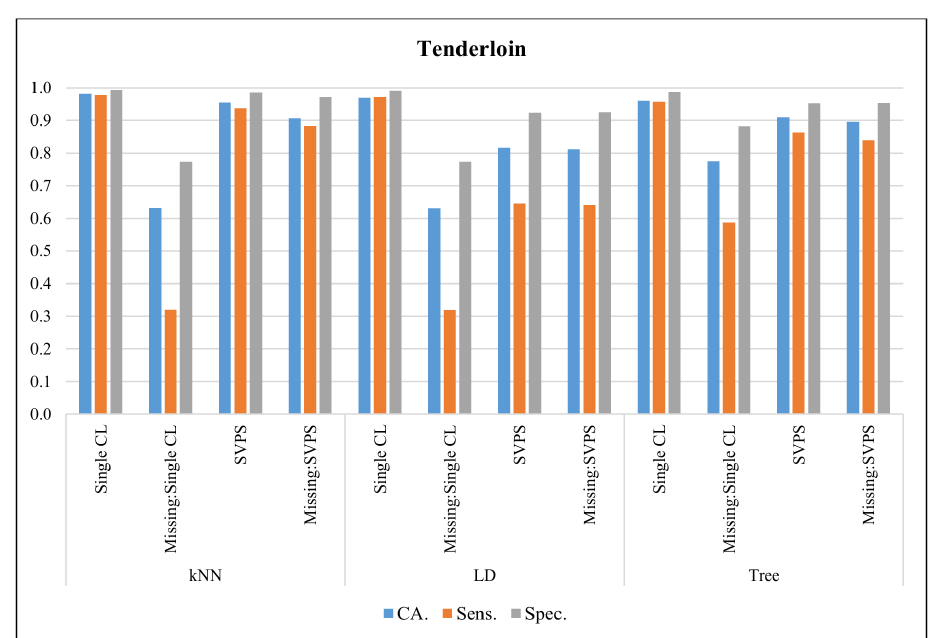
Figure 7. Classification results for Striploin dataset.